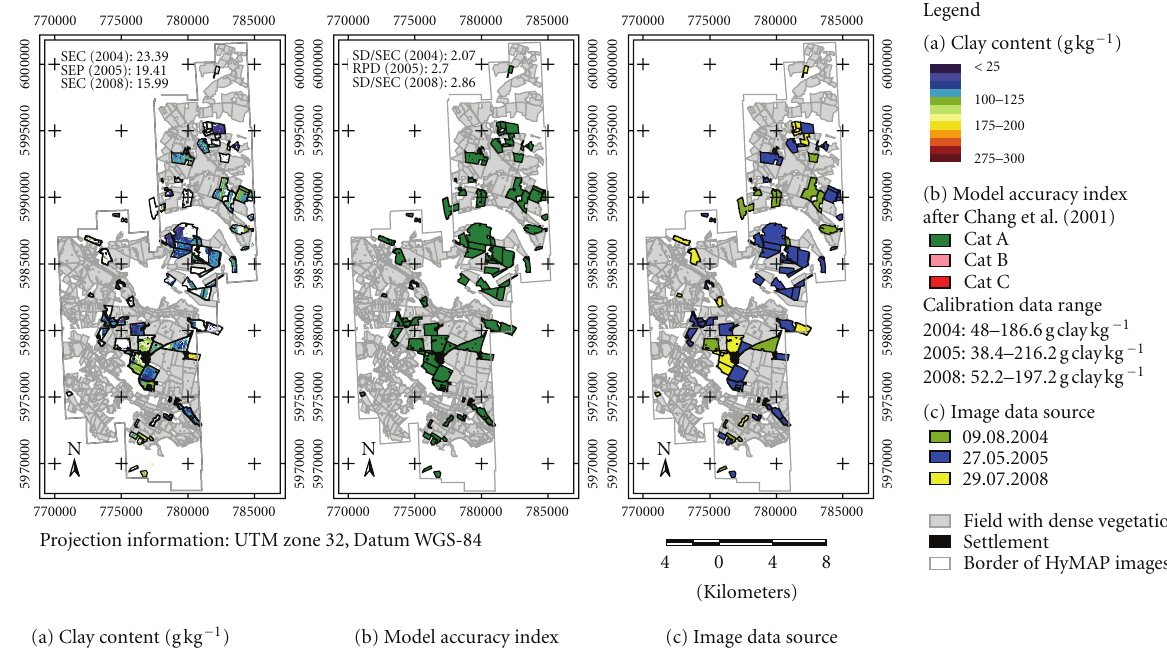
Figure 12: Map of soil clay content on agricultural fields (a) derived by multi-annual hyperspectral image data analysis. Map of RPD values (b) indicate field-specific model predictive ability after Chang et al. [56]. A field assignment to the year of acquisition is illustrated in Map (c).